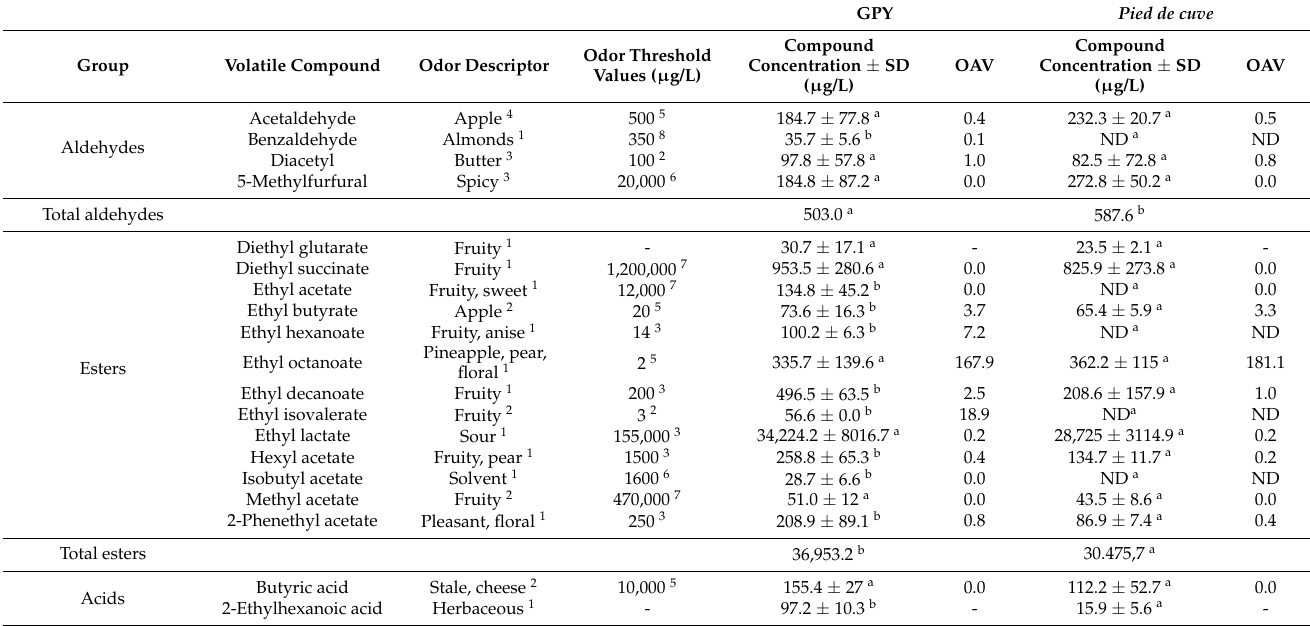
Table 3. Odor descriptor, odor threshold value, concentration, and OAV value for each component of the aromas found in the sparkling wines fermented with the GPY-grown and the pied de cuve -prepared S. cerevisiae IOC 18-2007. The ANOVA analysis results are shown as letters on the data corresponding to the concentration of aromatic compounds: different letters on the same line denote significant differences of 95%. OAV calculated by dividing the concentration by the odor threshold value of the